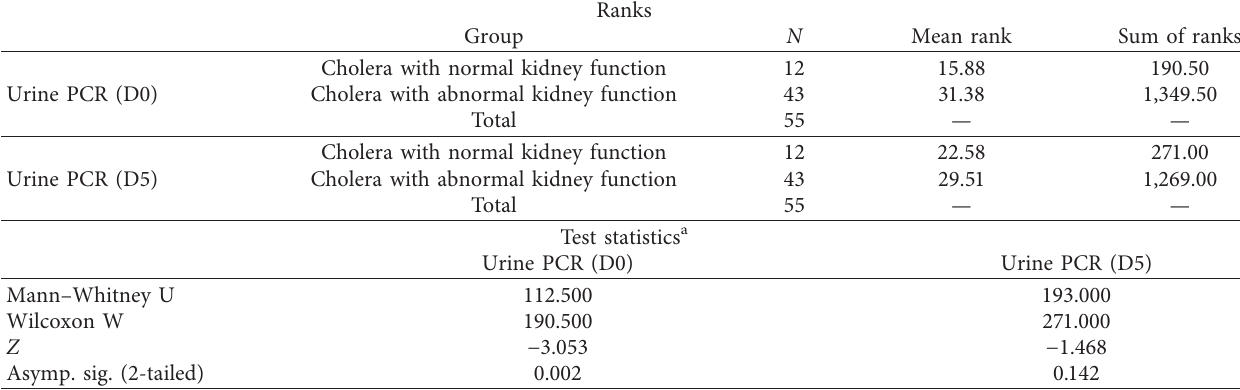
Table 4: Correlation of proteinuria (urine PCR) with